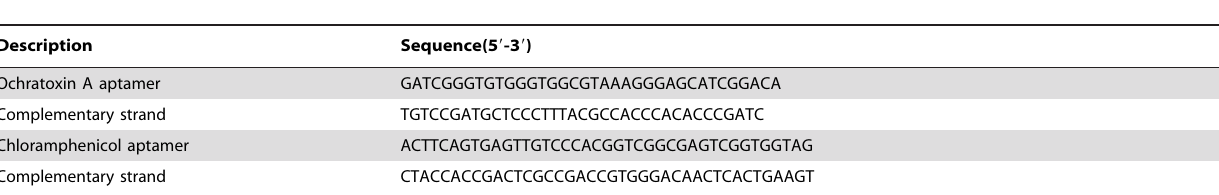
Table 1. Aptamer and complementary sequences used in this study.